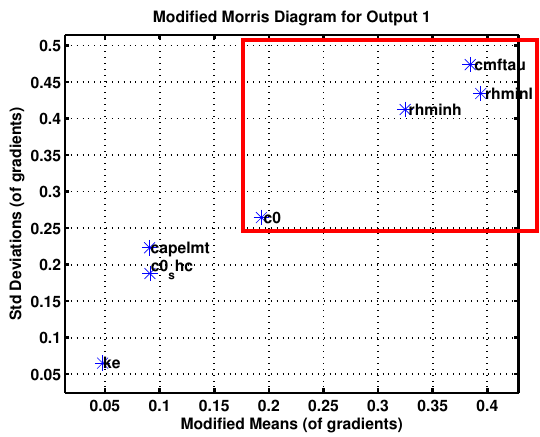
{hours used for a single 5-year model run}. In the GAMIL2 case, each ×